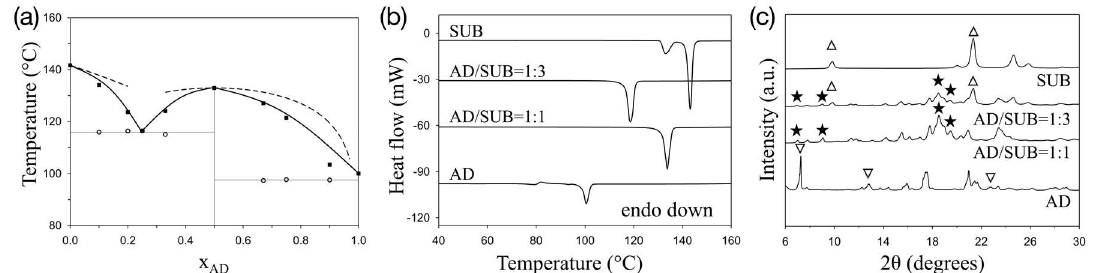
Figure 3. AD/SUB system: ( a ) melting diagram; ( b ) representative DSC thermograms; ( c ) representative XRD patterns. Top dashed lines in the melting diagram represent ideal liquidus lines. Some X-ray diffractions are marked as stars, triangles, and inverse triangles for cocrystal, SUB, and AD, respectively.